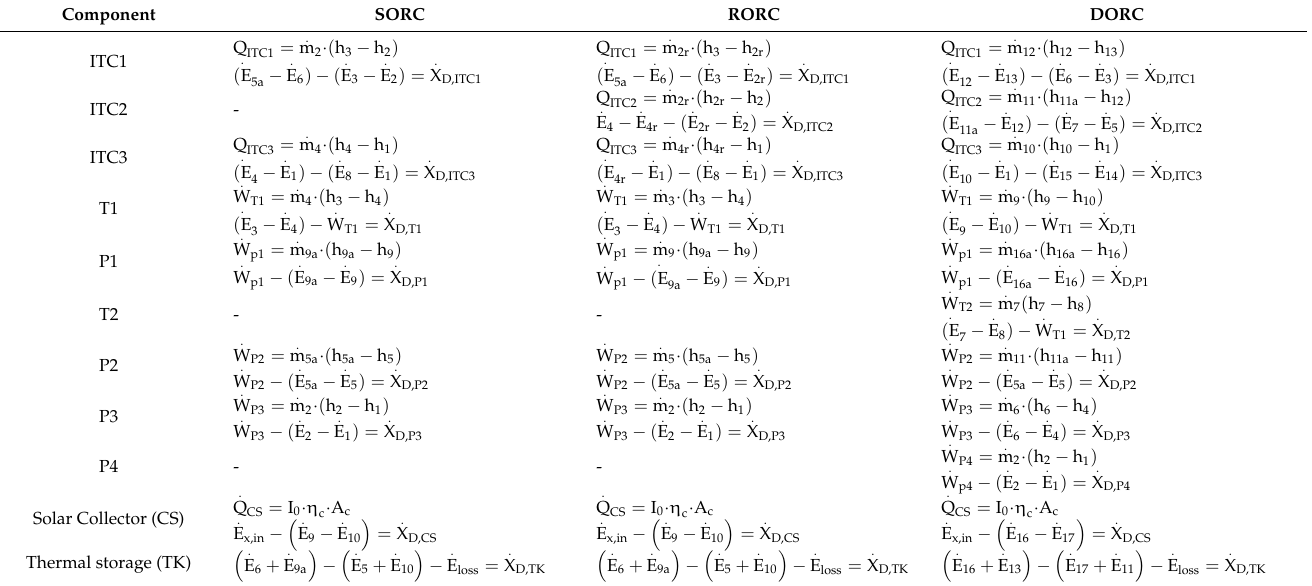
Table 1. Energy and exergy balance for the components of each